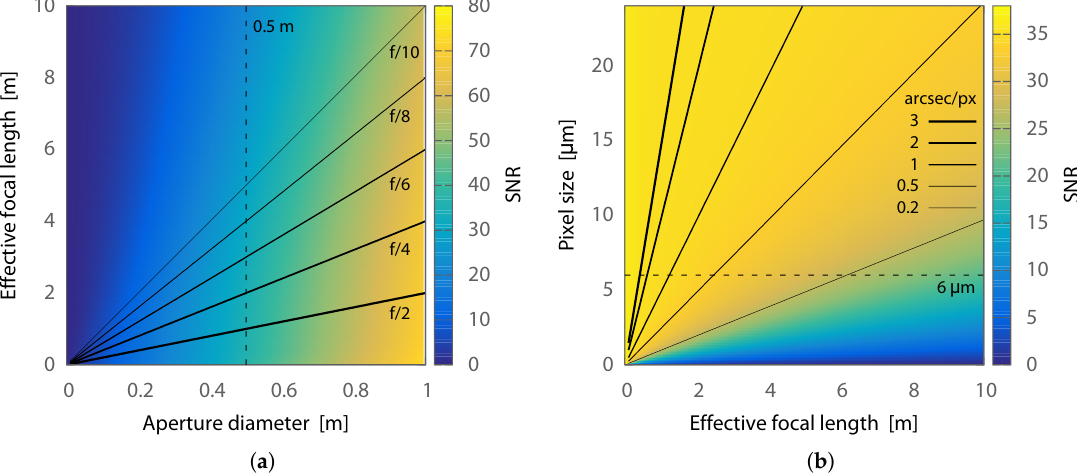
Figure 4. ( a ) aperture diameter, a proxy for area, has the strongest influence on signal-to-noise ratio (SNR) of an unresolved RSO. However, for a given aperture, there is also an improvement in SNR at shorter focal lengths. This plot assumes 6µm pixels; ( b ) oversampling an unresolved RSO spot reduces the photometric SNR by increasing the sky background and read noise for a constant 1FWHM photometric aperture radius. This plot assumes a 0.5m